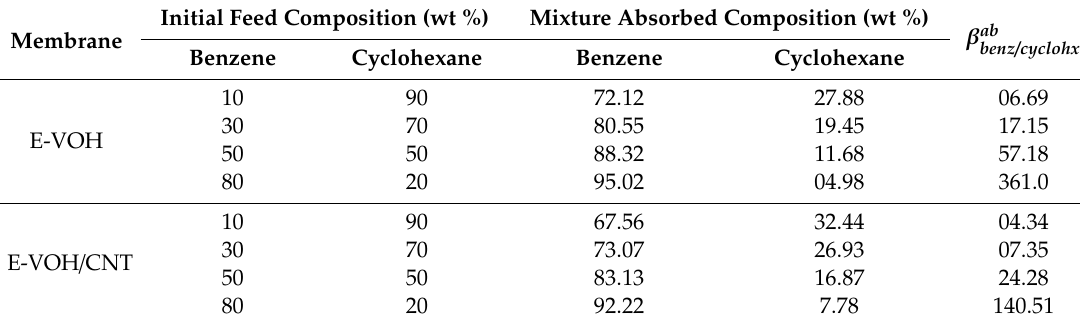
Table 5. Compositions of the benzene / cyclohexane mixture absorbed and the selective absorption factor of the E-VOH and E-VOH / CNT membrane